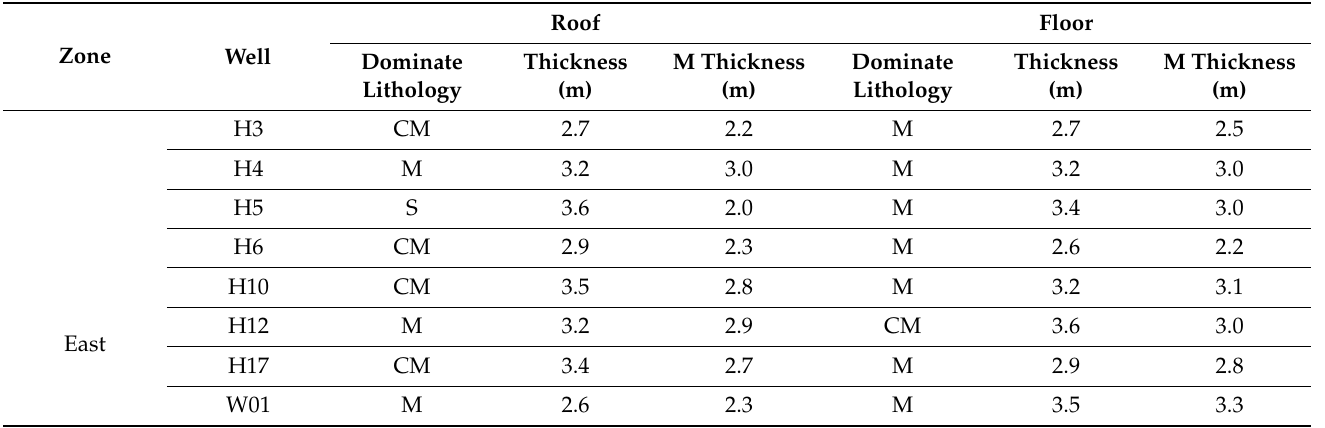
Figure 4. The distribution of gas content of the No.5 coal seam in the Weibei Field. Table 2. The thickness, roof lithology, and floor lithology of the No.5 coal seam of 16 CBM wells in the Weibei Field. Note: M = Mudstone, S = Sandstone, CM = Carbonaceous mudstone, SM = Silty Mudstone, AS = Argillaceous